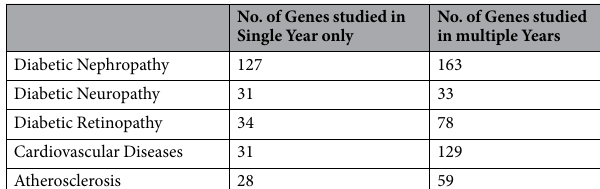
No. of Genes studied in multiple Years